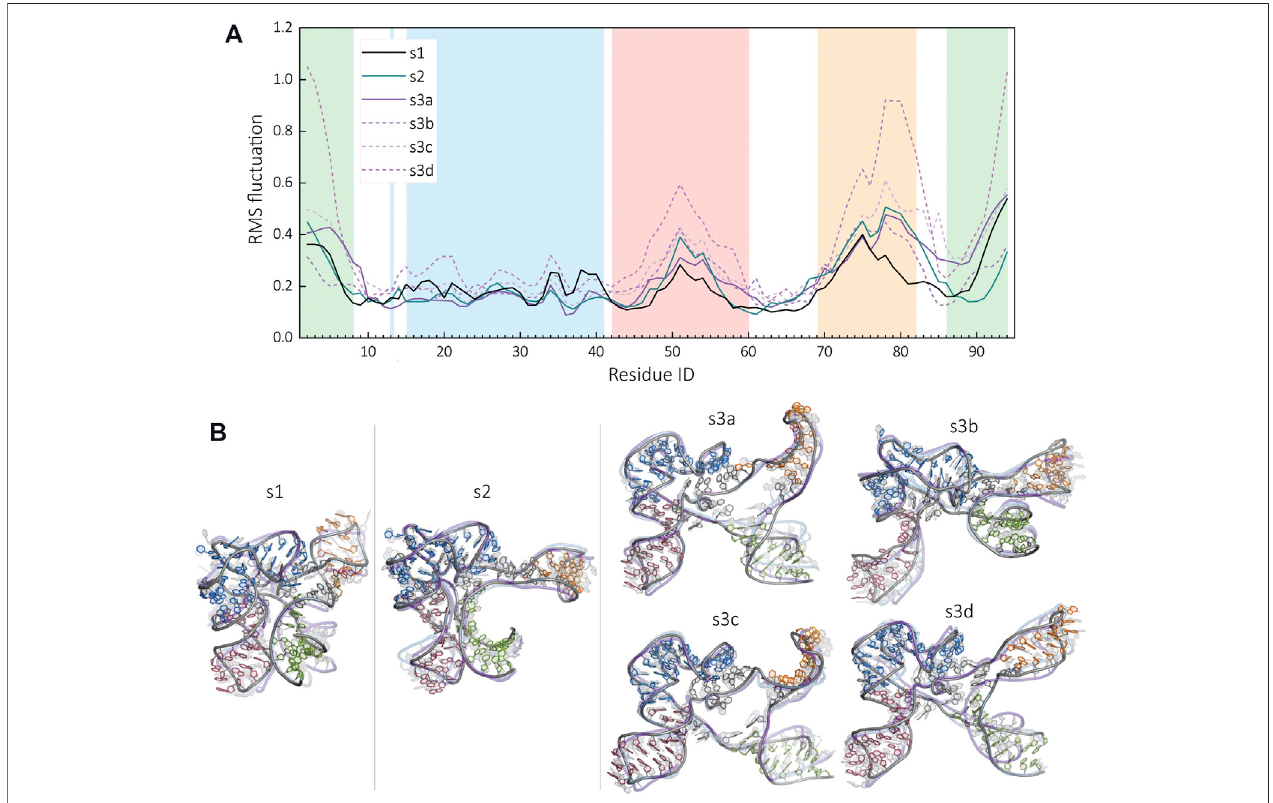
FIGURE 8 | Comparison of the structural dynamics of SAM-I riboswitch at each functional states. (A) RMS fl uctuations along the backbone of the RNA in the presence of SAM and Mg 2+ (s1, black), in Mg 2+ and without the ligand (s2, blue) and in the absence of divalent and SAM (s3, purple). The regions of the riboswitch, namely, P1, P2, P3, and P4, are highlighted in green, blue, red, and orange, respectively. (B) Structural dynamics is compared by showing the most populated clusters for each condition obtained by